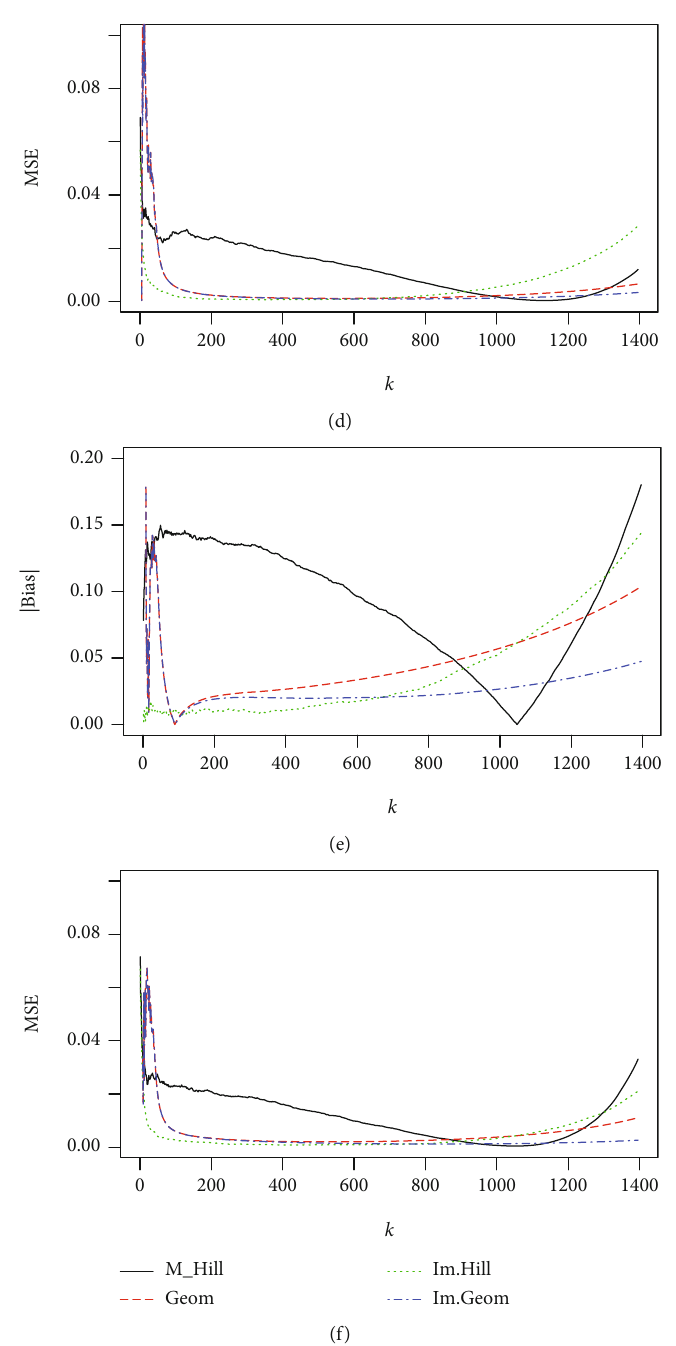
Figure 4: Results of ̂ ξ ð k Þ from Burr distribution with n = 2000 . (a, c, and e) Absolute bias. (b, d, and f) MSE. (a, b), (c, d), and (e, f) are 10%, 30%, and 60% missingness,